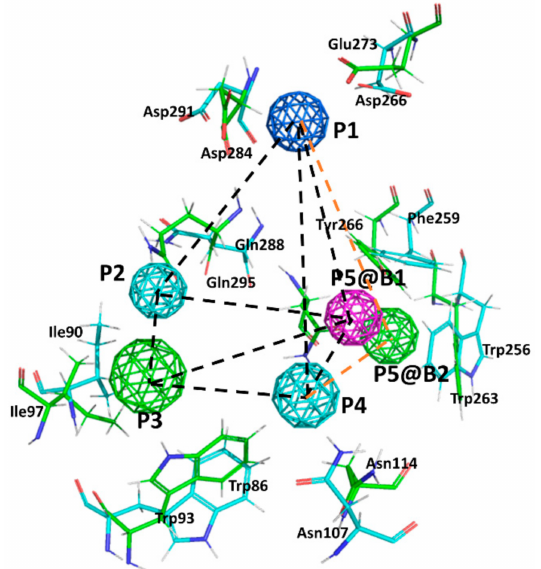
Figure 3. Superposition of the B1 and B2 receptor pharmacophores. Colored spheres represent pharmacophore points (P1–P5) according to the following color code: dark blue represents a positive charge moiety; magenta a hydrogen bond accepting center; light blue a hydrogen bond donor / acceptor center; green an aromatic / lipophilic center. @B1 and @B2 is used to di ff erentiate P5 for the B1 and B2 receptors, respectively. Consensus distances between common pharmacophore points are (black dotted lines): d(1,2) = 9 Å; d(1,3) = 14 Å; d(1,4) = 10.5 Å; d(2,3) = 6 Å; d(2,4) = 7 Å; d(3,4) = 7.5 Å. Specific distances for the B1 pharmacophore: d(1,5) = 9.5 Å; d(2,5) = 9.3 Å; d(3,5) = 9.5 Å; d(4,5) = 5.7 Å; whereas for the B2 pharmacophore are (orange dotted lines): d(1,5) = 11 Å; d(2,5) = 9 Å; d(3,5) = 8.8 Å; d(4,5) = 8.4 Å. Side chains of the main residues involved in defining the binding pocket for non-peptide ligands are explicitly depicted: green for the B1 and blue for the B2,